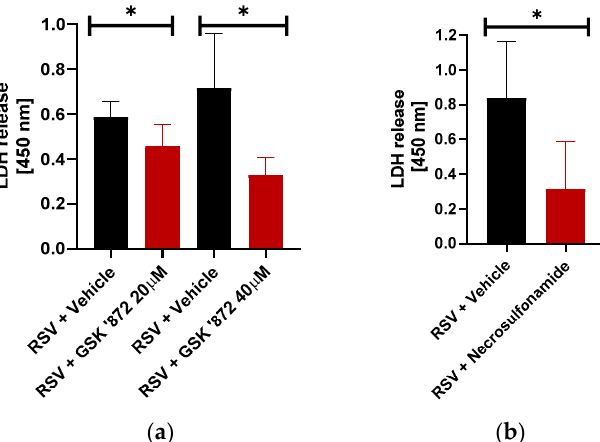
Figure 3. Necroptotic cell death of RSV-infected macrophages via RIPK3-MLKL pathway. ( a ) Human THP-1 macrophages were infected with RSV (MOI = 1) in the presence of either vehicle (DMSO) or RIPK3 inhibitor GSK’872 (20 µ M and 40 µ M). LDH release was measured (at OD of 450 nm) at 16 h